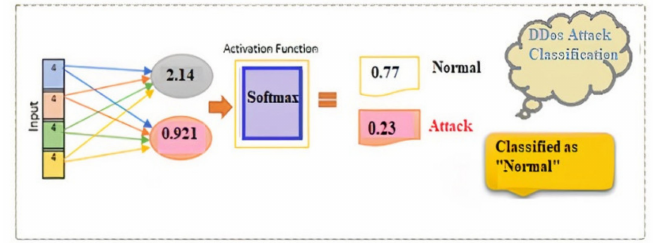
Figure 3. Classification using the softmax function. Algorithm 1 shows the pseudocode processes of the suggested model for predicting DDoS